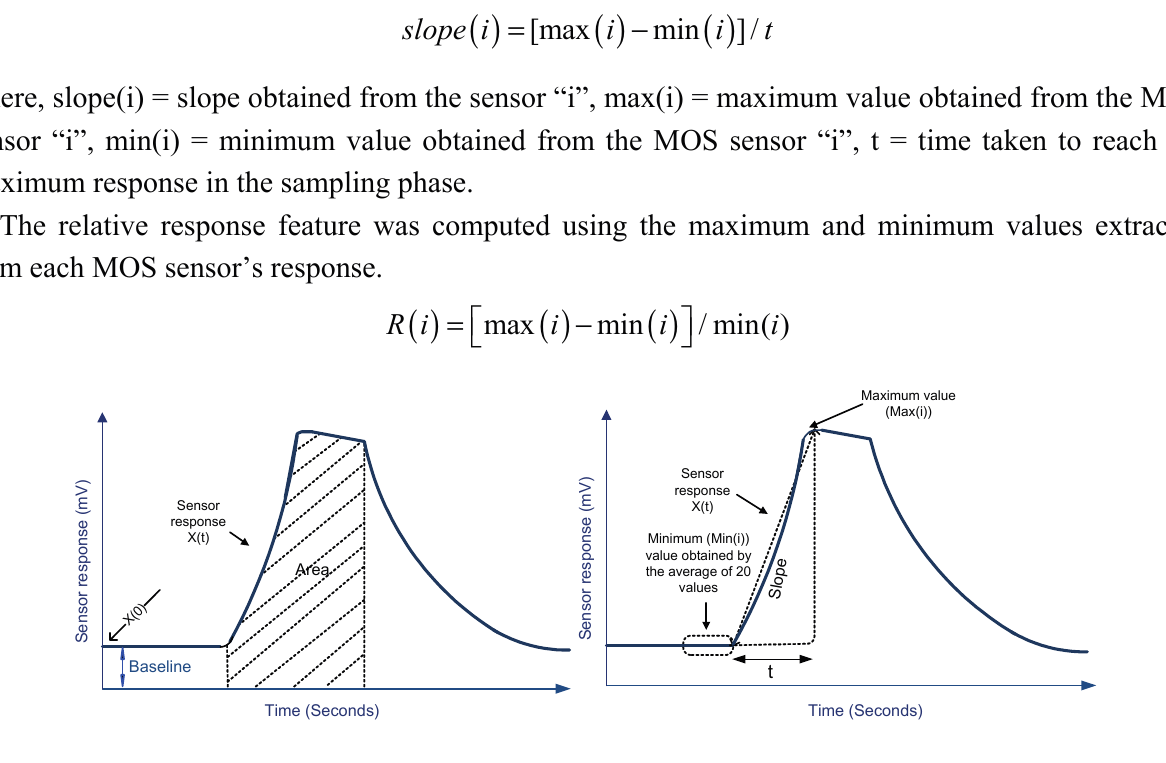
Figure 7. A typical response of a MOS sensor and the features extracted from the response. Similarly, features were calculated from all the MOS